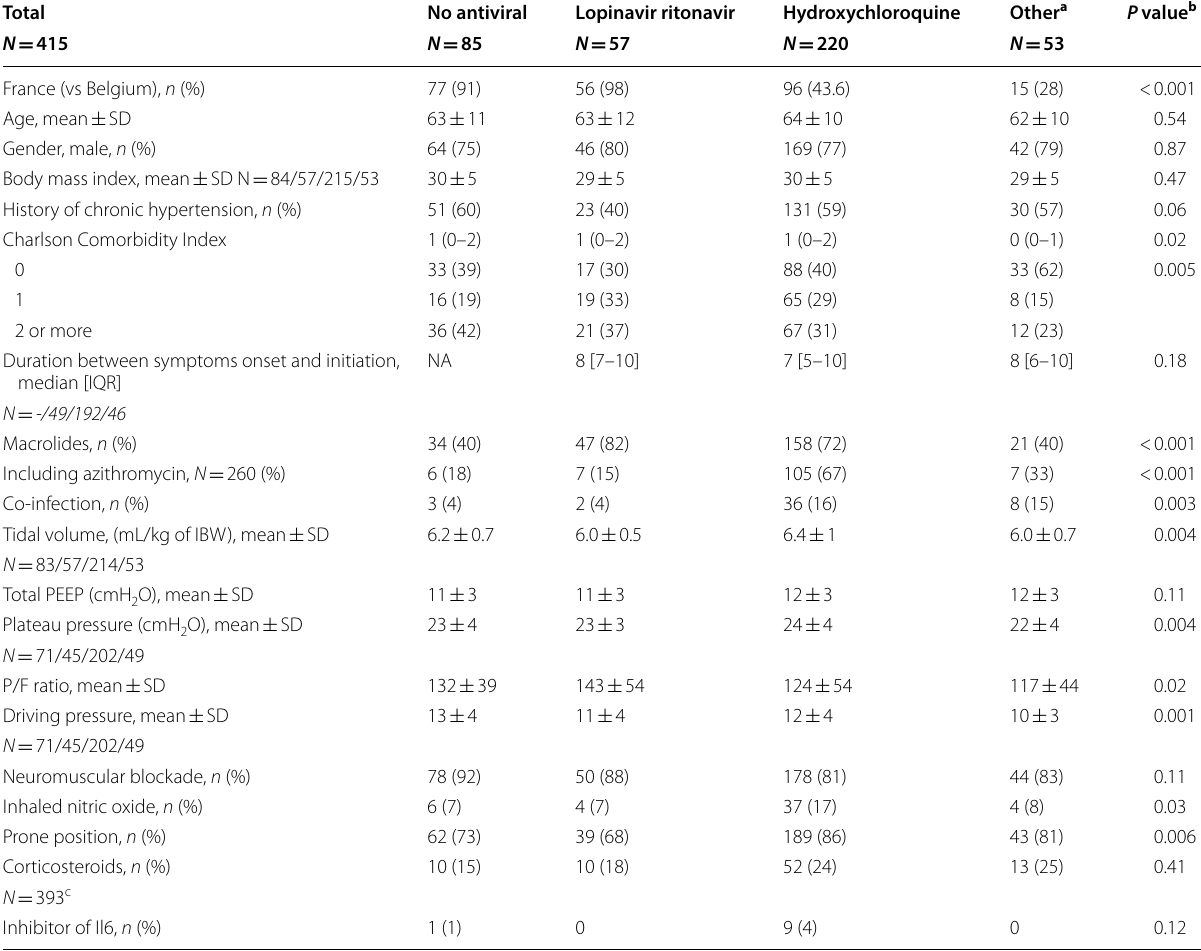
Table 1 Patients’ characteristics according to antiviral